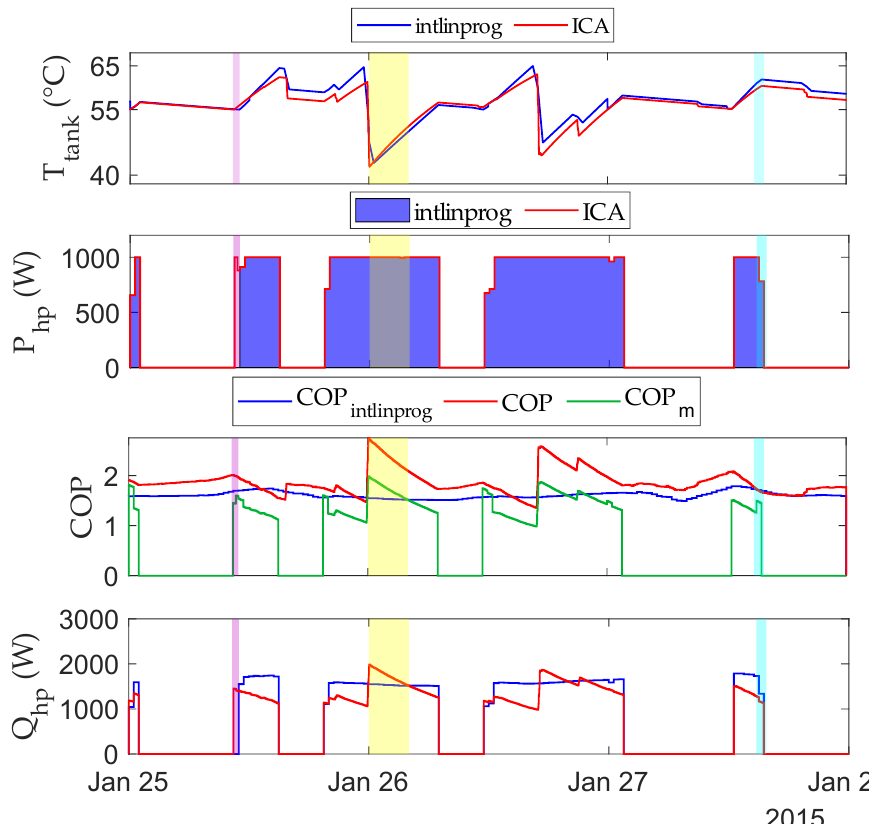
Figure 6. Tank temperature ( T tank ), HP coefficient of performance ( COP m considers part-load efficiency, COP does not), electric and thermal power ( P hp and Q hp ) given by intlinprog and the instantaneous control algorithm (ICA). This scenario comprises a 1-kW heat pump, 600-L domestic hot water storage and 3-kWp PV system. Yellow and blue areas highlight COP and COP m differences between intlinprog and the ICA. The purple area shows that the ICA was forced to use additional HP power not expected by intlinprog to keep the tank temperature over the set point (55 ◦ C). The cause of this is the different DHW profiles used by intlinprog and ICA at 30-min and 1-min time steps as well as the COP mismatch between